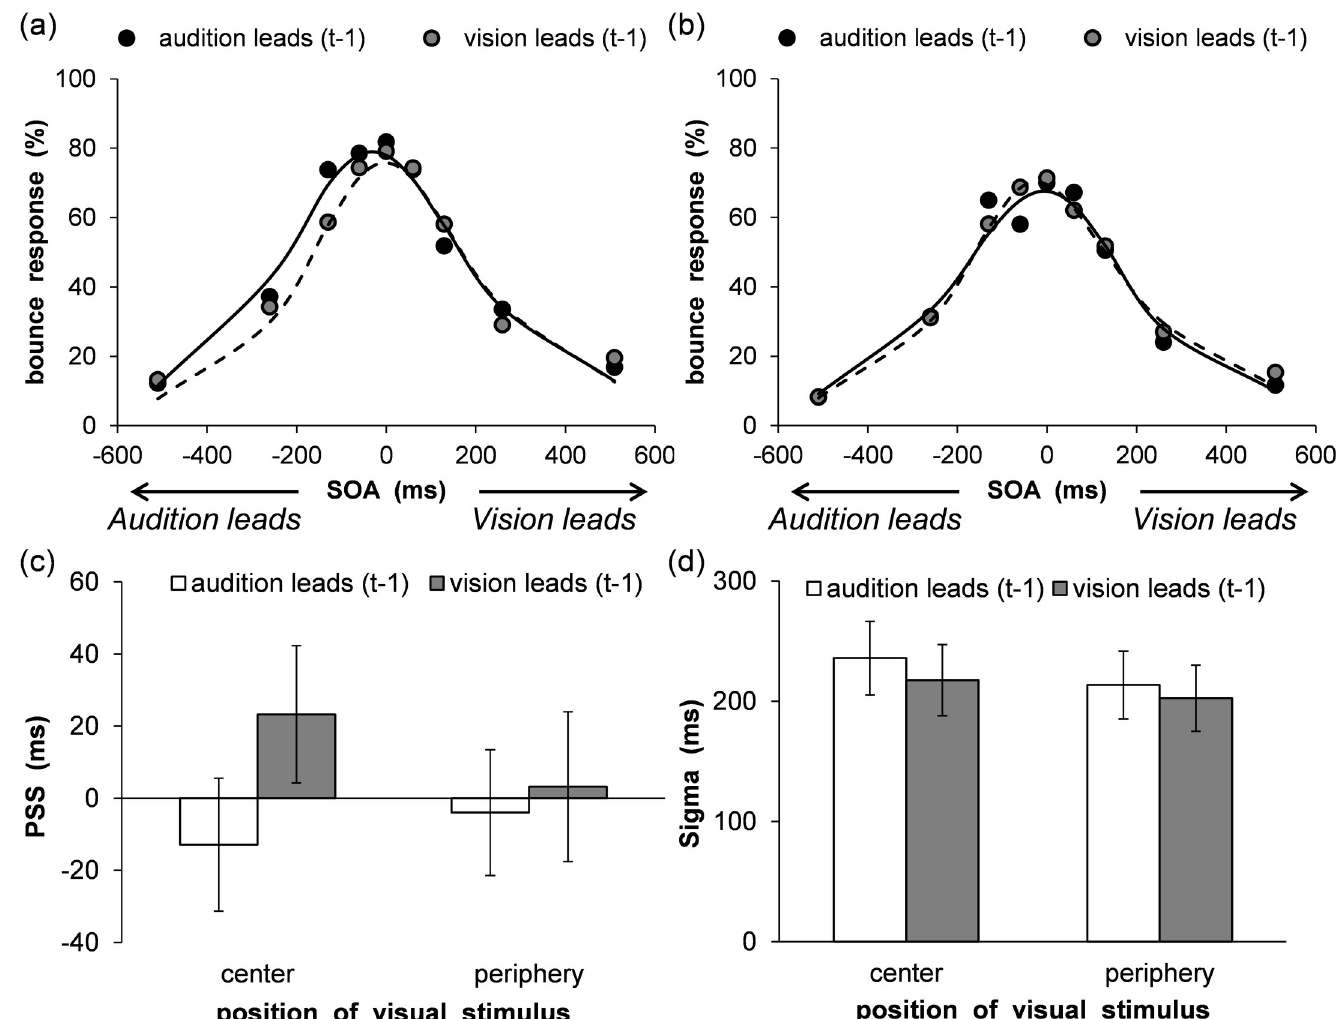
Fig 8. Results of rapid recalibration analyses in Experiment 3. Mean percentage of bounce responses in the (a) central and (b) peripheral visual fields. The average fitting functions are plotted for preceding trials of audition leads and vision leads data. (c) Mean estimated point of subjective simultaneity. (d) Mean estimated sigma. Error bars represent standard errors of the mean ( n =